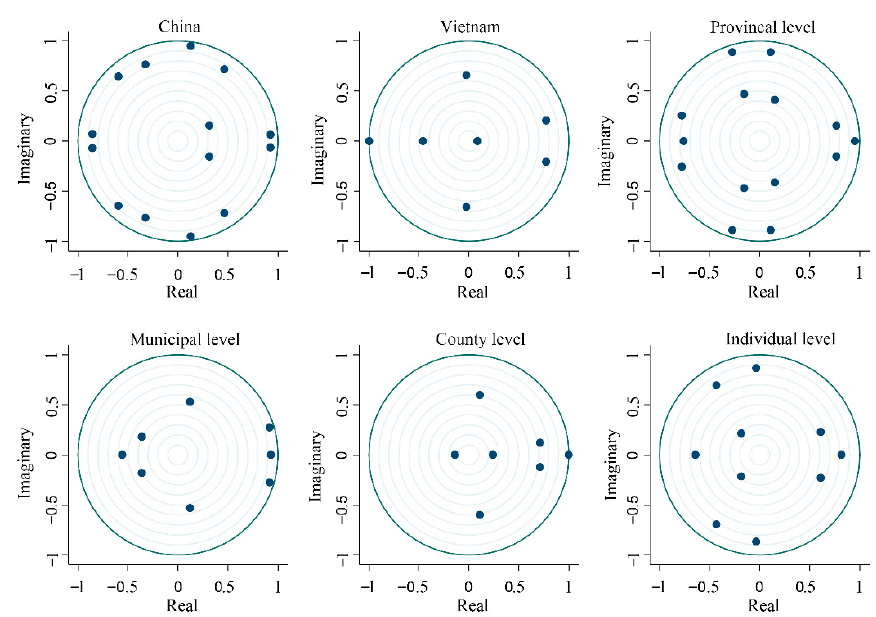
Figure 2. Discriminant diagram of VAR system stability at various scales.